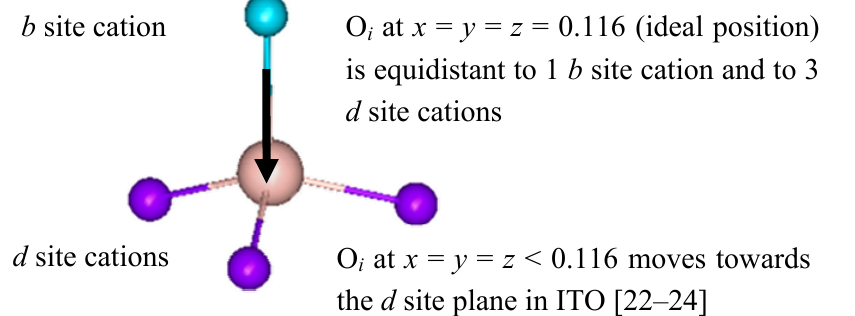
Figure 2. Nearest cations surrounding an oxygen interstitial located at the c sites in the bixbyite